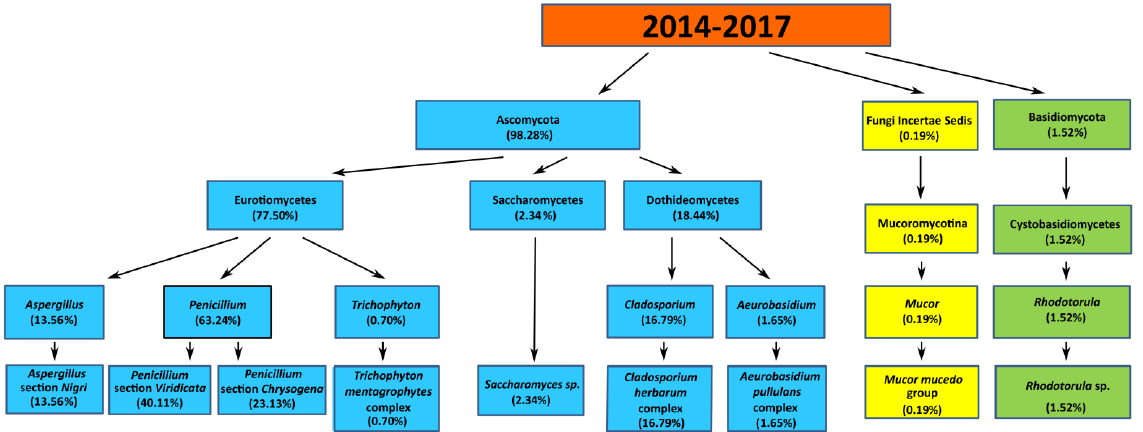
Figure 6. The percentage share of mold and yeast-like fungi in the air of the seaside towns (Hel, Puck, Gdynia, Sopot, and Gdańsk-Brzeźno) in the years 2014–2017.